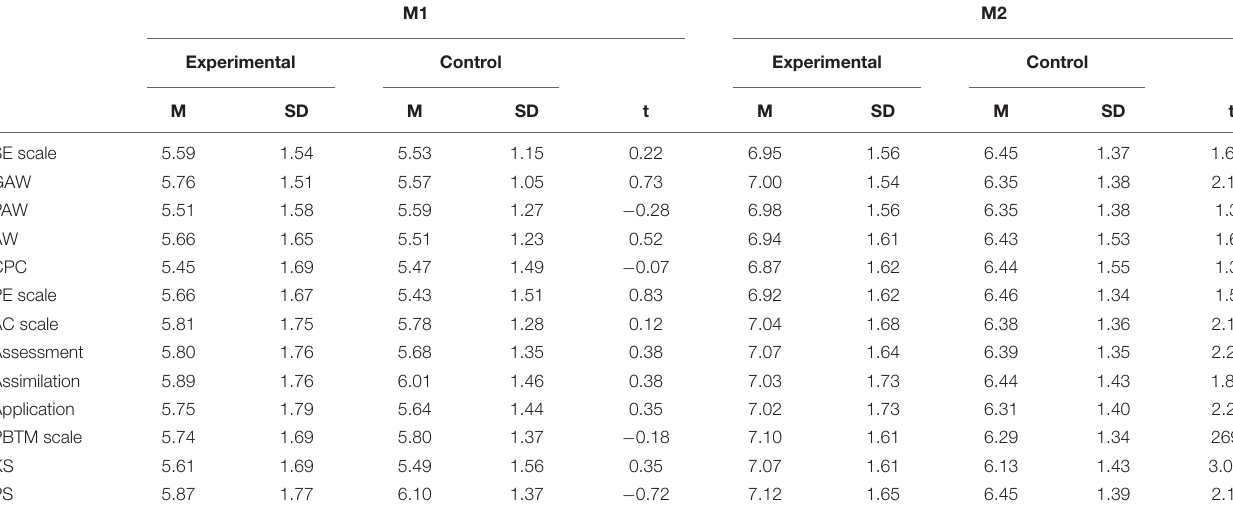
TABLE 3 | A study of the independence value between experimental and control